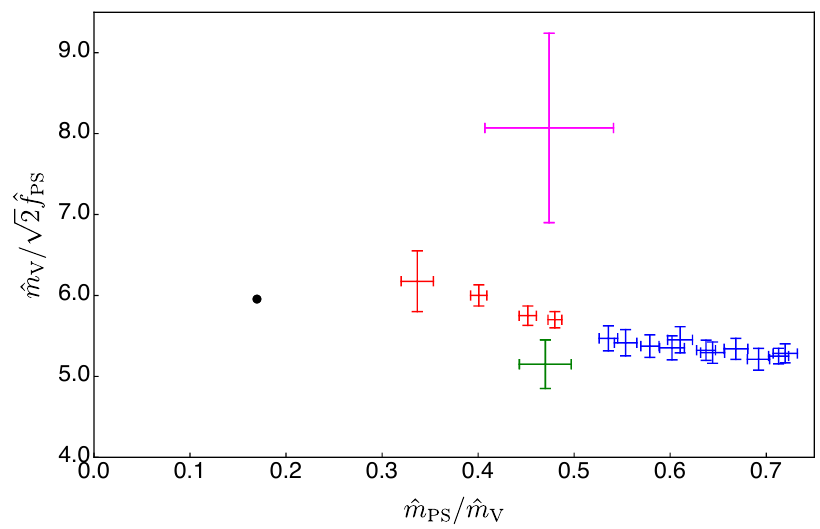
p 2 f PS in several